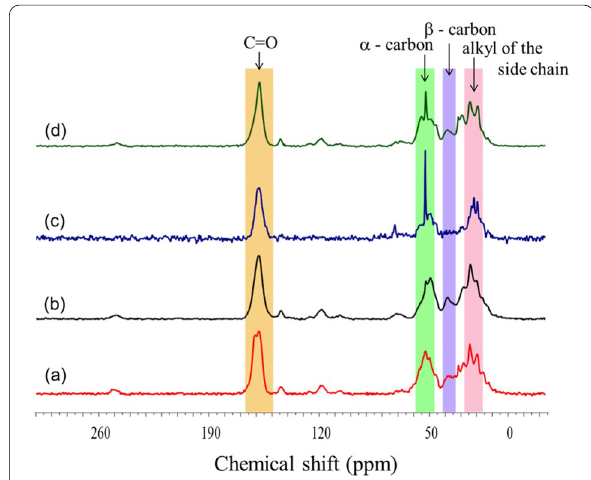
Fig. 3 The 13 C CP MAS NMR spectra of keratin isolated from waste b animal wool c human hair d chicken feather and comparison with a standard wool keratin